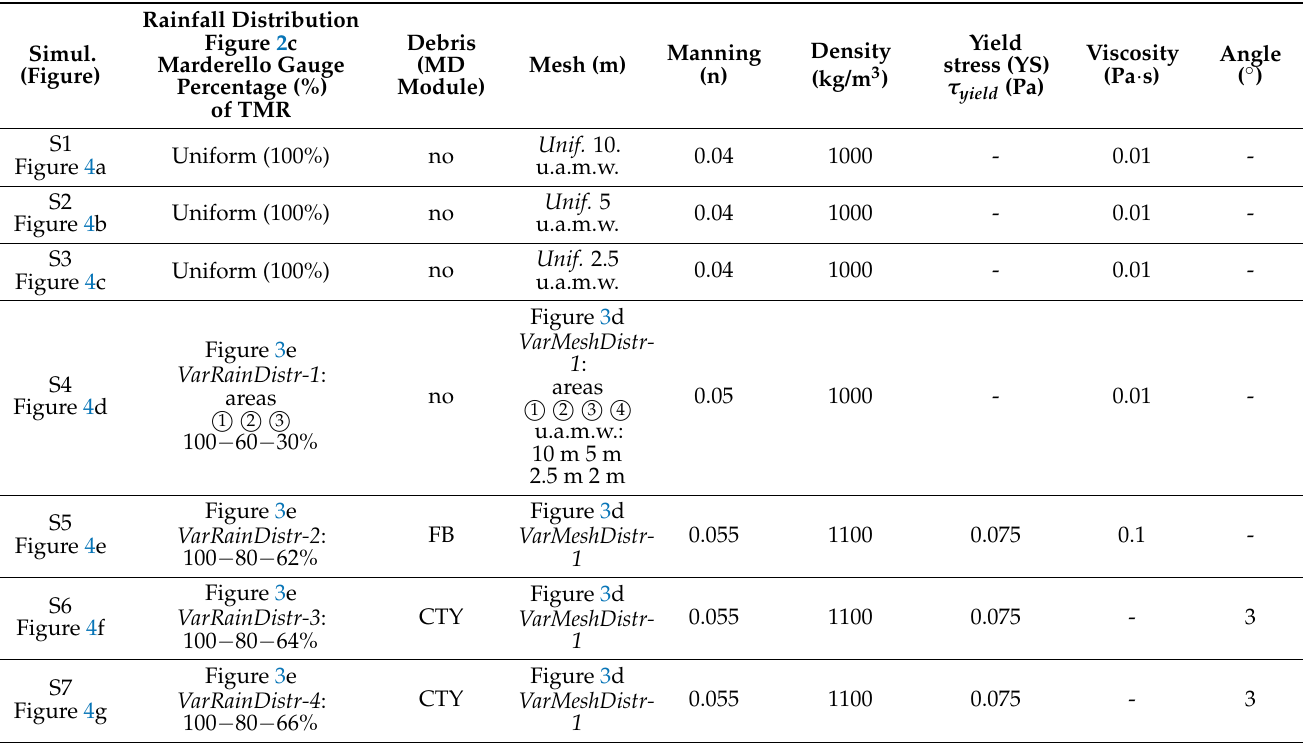
Table 1. Summary description of the main parameter numerical values assumed for preliminary simulations based on only Marderello rainfall time history; TMR: Total Measured Rainfall (mm/h); VarRainDistr-1, -2, -3, -4 variable rainfall distributions, percentage (%) of TMR, related to the selected areas 1, 2, 3; MD: Mud-Debris module; FB: Full Bingham; CTY: Coulomb-Turbulent-Yield; u.a.m.w.: uniform average mesh width (m), uniform ( Unif. ) within the whole area or uniform ( VarMeshDistr ) but with a different value in each of the 1, 2, 3, 4 subdomains areas.